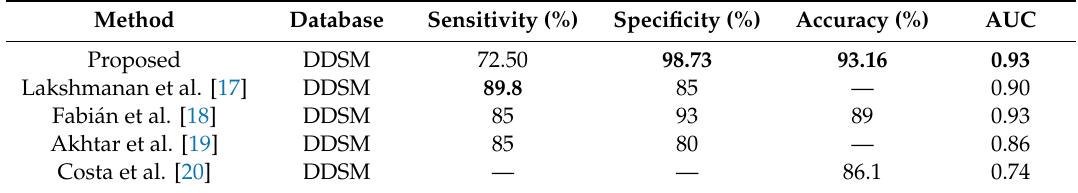
Table 8. Compare proposed methods with advanced